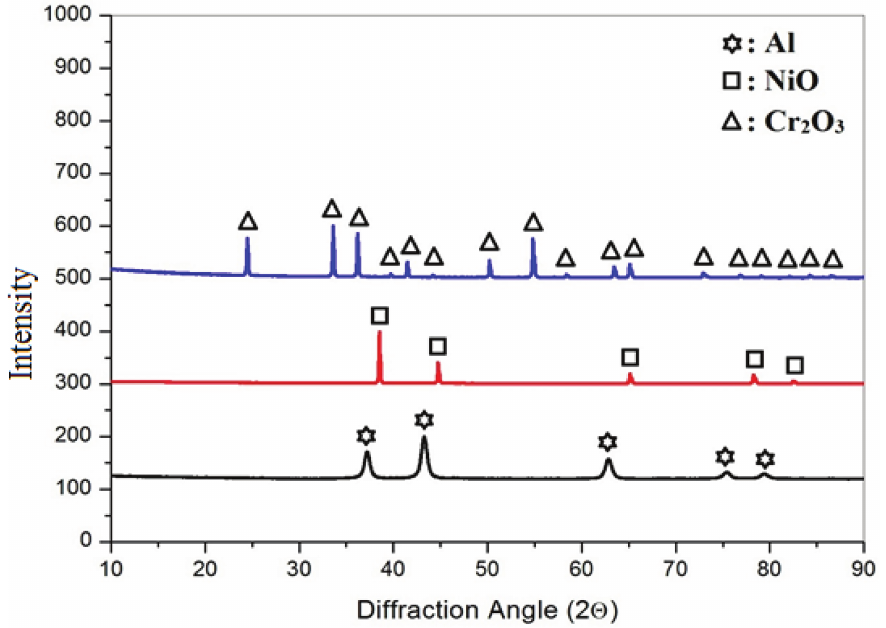
Figure 5: XRD patterns of selected reactants and reductant.